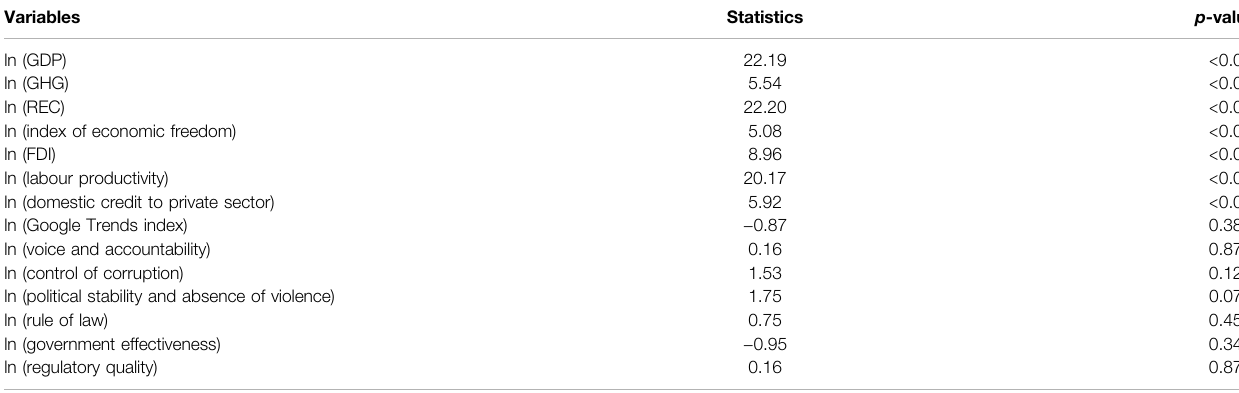
TABLE 2 | The CD Pesaran ’ s test – results (2006 – 2019).